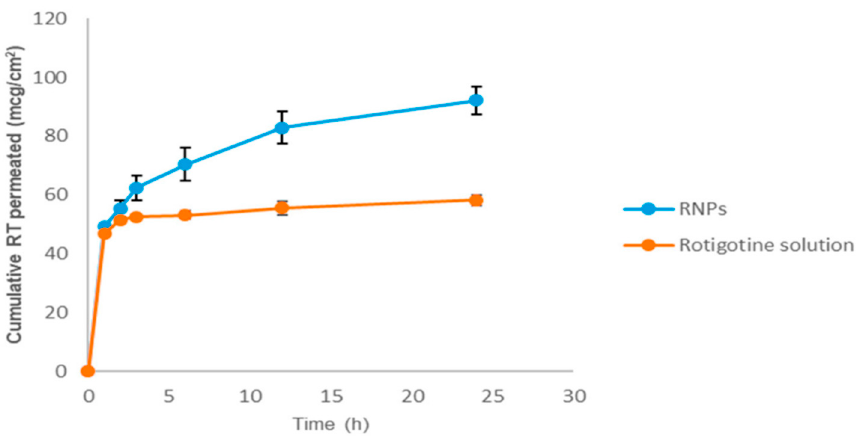
Figure 5. Ex vivo nasal permeation studies of rotigotine solution and rotigotine NPs in PBS at a pH of 7.4 (Reproduced from [112], MDPI, 2019).